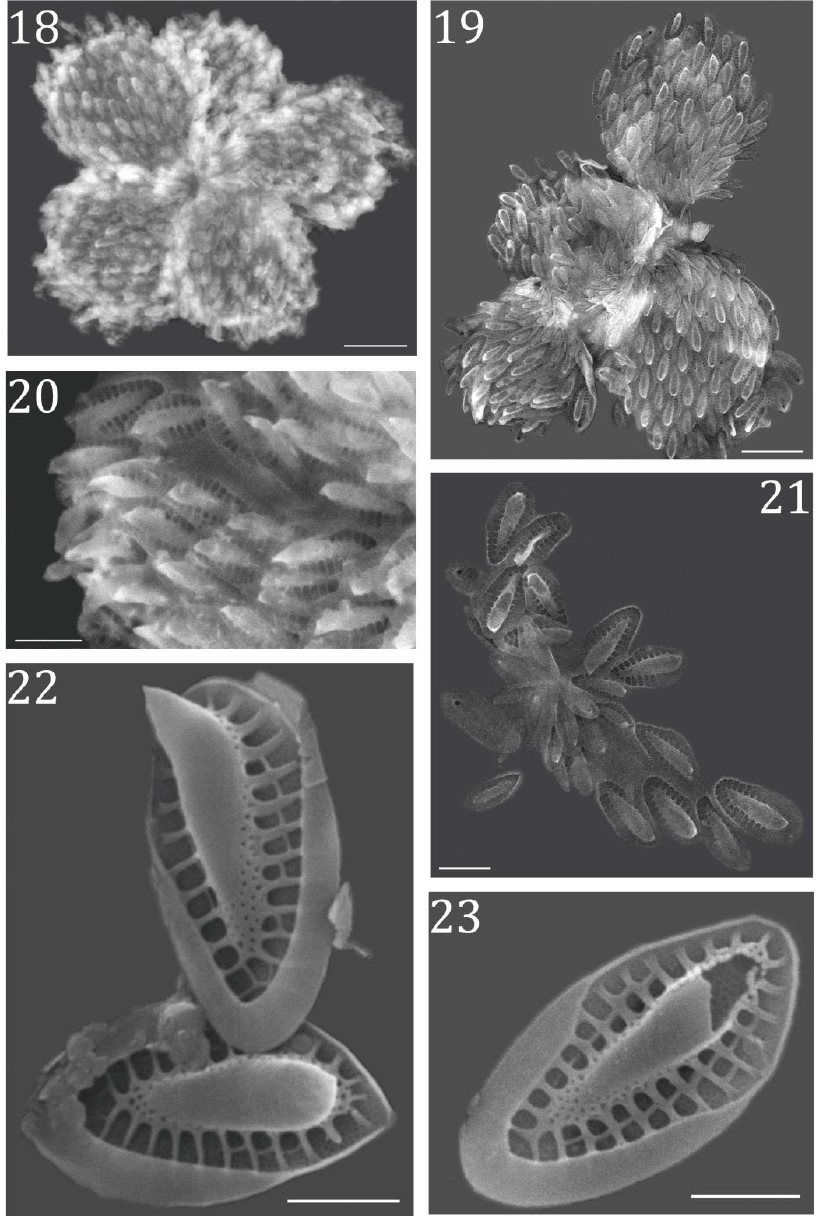
Figure 5. Morphological structures of Synura petersenii collected from Guizhou, China. ( 18 – 19 ) Colony (SEM); ( 20 – 21 ) Body scales (SEM); ( 22 ) Two body scales with well-developed keels, a great many struts, and posterior rim (SEM); and ( 23 ) A single body scale (SEM). Scale bars: ( 18 – 19 ) = 5 μ m, ( 20 – 21 ) = 2 μ m, and ( 22 – 23 ) = 1 μ m.